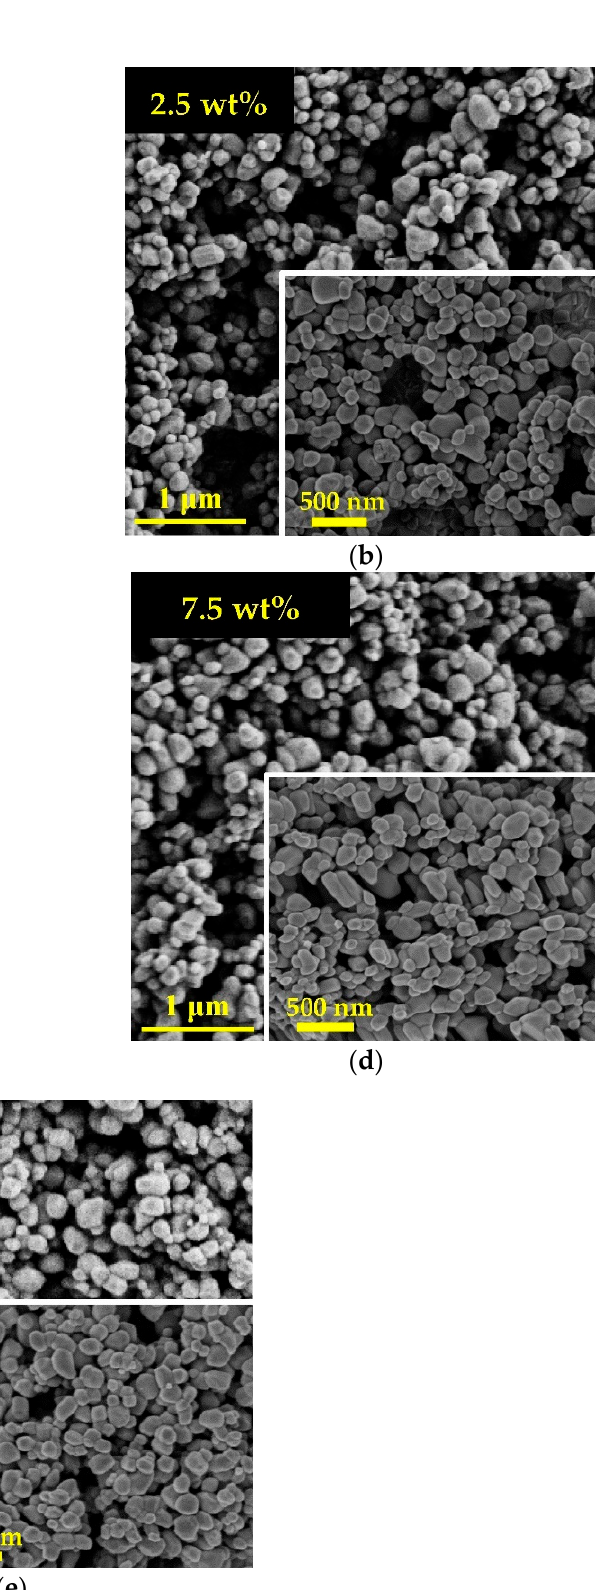
( d ) Figure 8. The cross-cut testing results of four samples, namely( a ) without the annealing and DMF dose, ( b ) with 350 °C annealing, ( c ) with preparation of 7.5 wt% DMF dose, and ( d ) with the 350 °C annealing and 7.5 wt% DMF dose. As shown in Figure 9, the porosity determined by the ImageJ software is defined by the ratio of the red area. The variation of determining porosity is shown in Figure 9f, il- lustrating that with the increasing DMF doses, the porosity value keeps consistent at ~40% from 0 to 5 wt%. The largest porosity of films is obtained at 350 °C, and then gradually decreases to 32.9% and 31.4% in the range of 7.5 to 10 wt%, respectively.